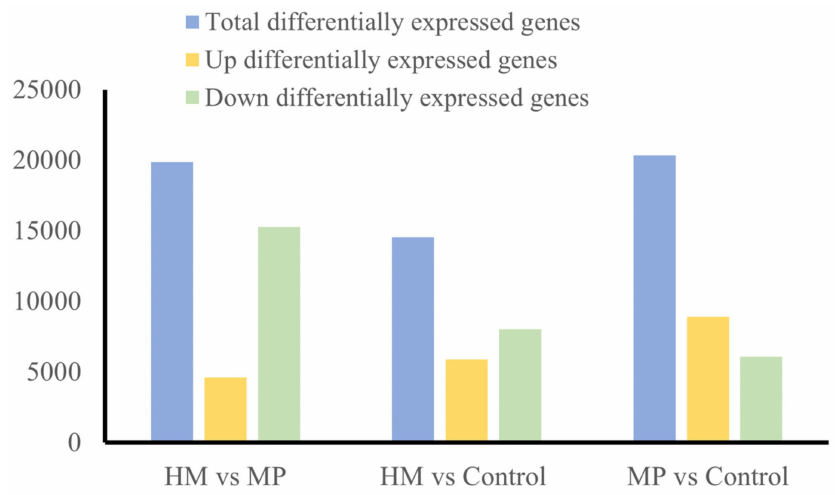
Figure 3. Differentially expressed genes in the liver transcriptome of H. erectus .